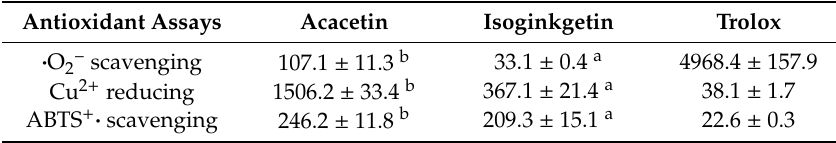
Table 1. IC 50 values of acacetin and isoginkgetin in various antioxidant assays ( µ